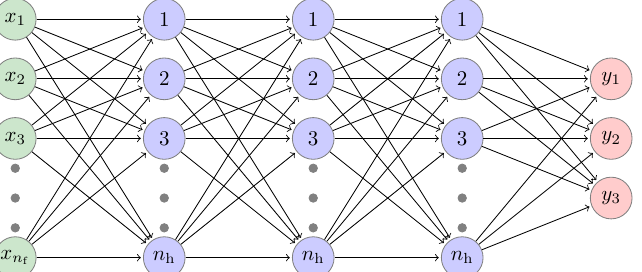
Figure 5. A DNN model with three hidden layers ( n d = 3) for classification of tripartite states. Green nodes represent input units where the number n f of features is equal to 4 for Mermin and 8 for Svetlichny inequality. Blue nodes represent the hidden nodes where the ReLu is chosen as the activation function. Red nodes represent the output units where Softmax is used as the activation